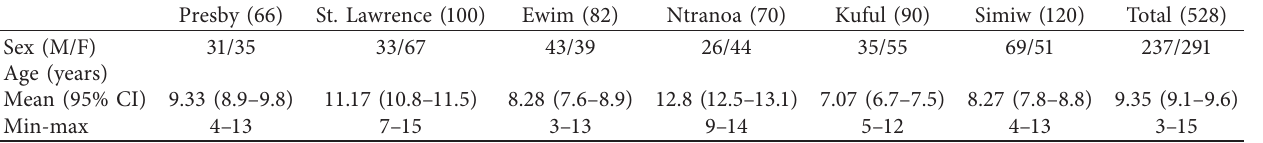
Table 1: Demographic characteristics of enrolled children.